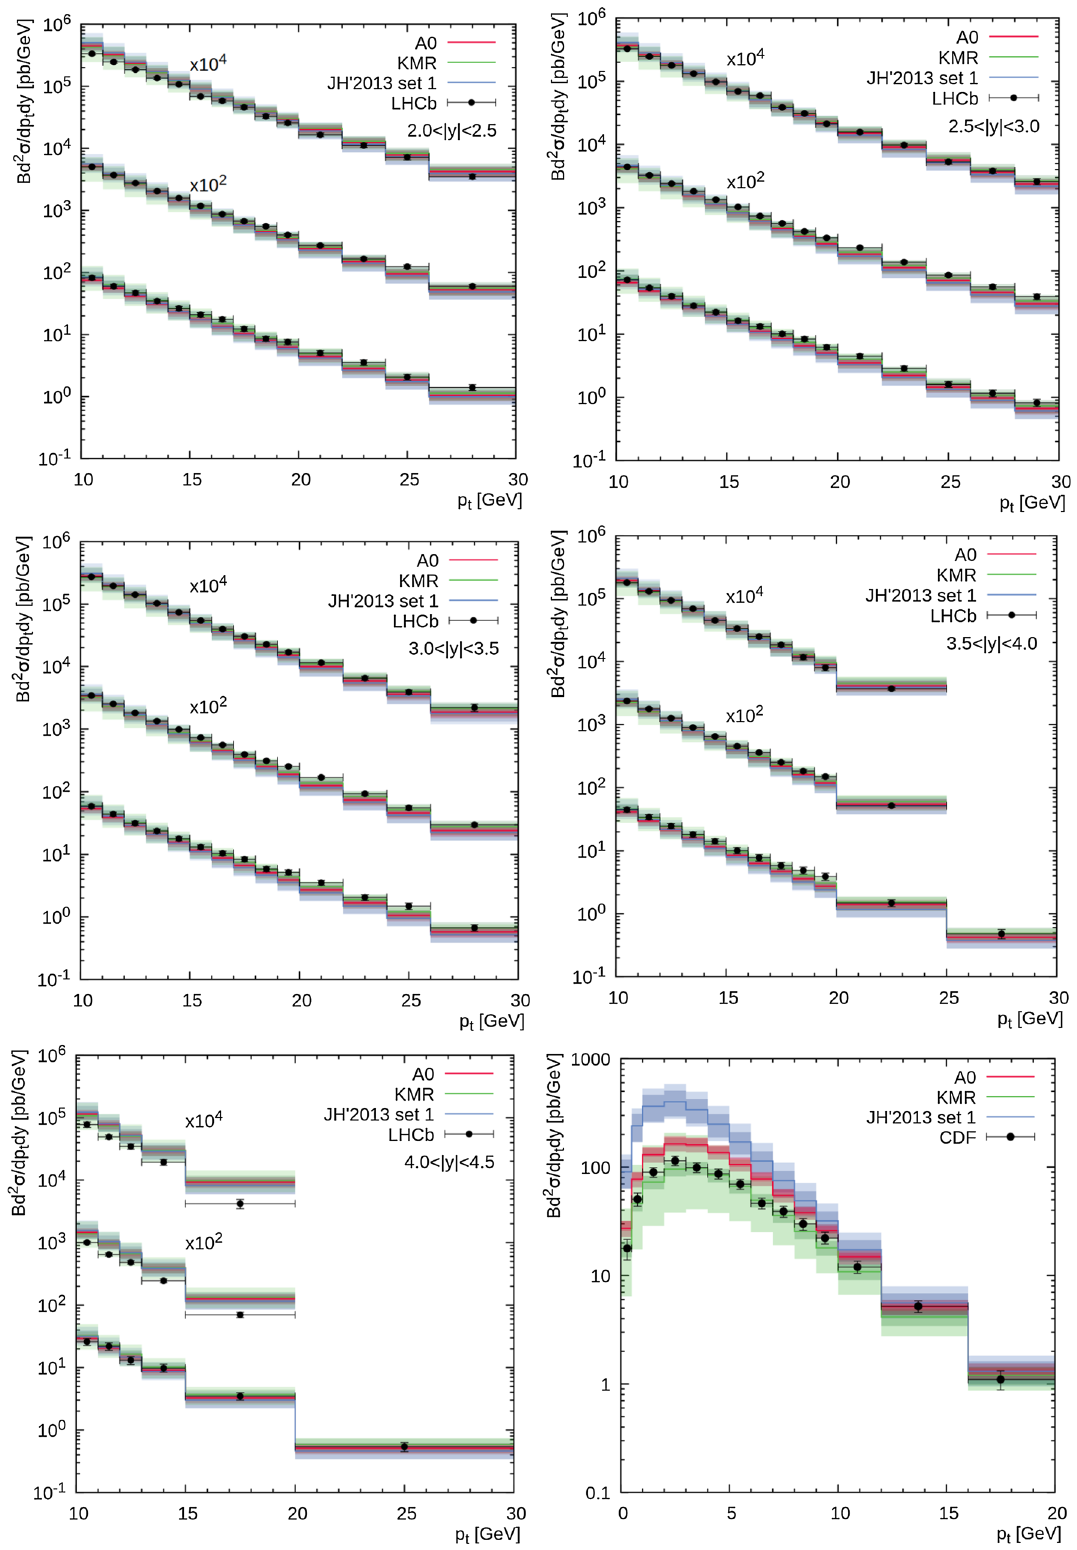
√ s = 1 . 8, 7, 8 and 13 TeV in the different rapidity